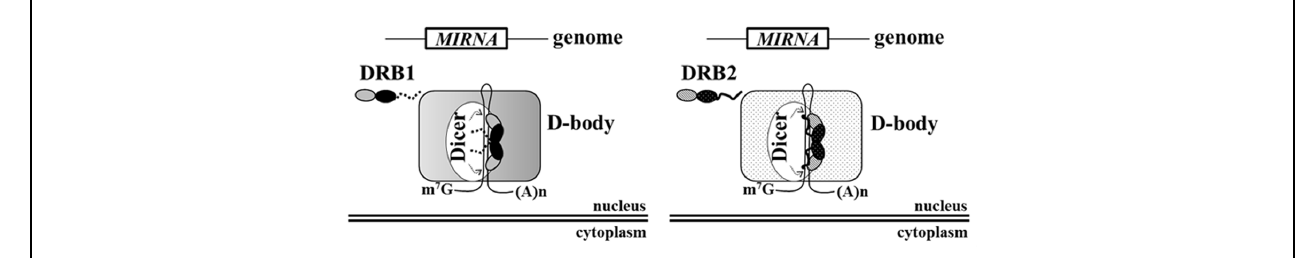
FIGURE 7 | Hypothetical model for the role of DRB1 and DRB2 domains. miRNAs are encoded as gene-like structures and are recognized by a dicer (DCL1) and a DRB protein. DRB1 dsRBD1 recognizes dsRNAs and its dsRBD2 promotes dimerization and interaction with other proteins, without the aid of its C-terminus (shown as a dotted line). DRB2 dsRBD1 also recognizes dsRNAs and its dsRBD2 appears to mediate different protein–protein interactions to those of DRB1, possibly assembling dicing bodies (D-bodies) different to those containing DRB1. This may also require the presence of the DRB2 C-terminus (shown as a continuous